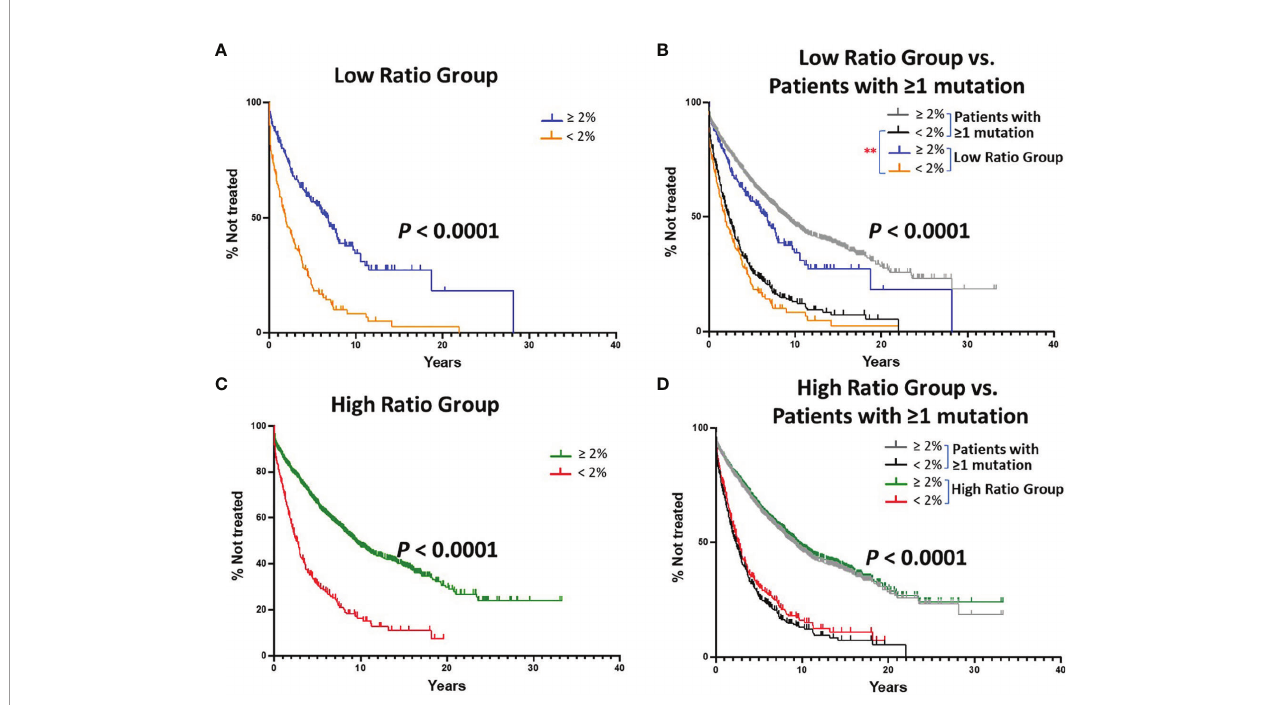
FIGURE 2 | Kaplan-Meier estimates of TTFT of patients with IGHV sequences bearing at least 1 somatic mutation divided into Low or High (S+Rc)/Rnc Ratio Groups. (A) TTFT of patients with IGHV genes falling into the “ Low Ratio Group ” , ≤ 1.0 (S+Rc)/Rnc (n = 405) were compared based on the < 2% vs. ≥ 2% difference from the germline IGHV sequence. Number of cases in the < 2% difference group: 183, 152 treated (median TTFT = 1.91 years); number of cases in the ≥ 2% difference group: 222, 119 treated (median TTFT = 6.78 years) (P < 0.0001). (B) TTFT of all patients ( Figure 1B ) and those sequences in Low Ratio Group based on the < 2% vs. ≥ 2% difference from the germline IGHV sequence. ** = P < 0.01 Pair-wise Log-rank (Mantel-Cox) test. (C) TTFT of patients in the High Ratio Group, > 1.0 (S+Rc)/Rnc) (n = 1,934) compared based on the 2% cutoff. Number of cases in the < 2% difference group: 271, 199 treated (median TTFT = 2.59 years); number of cases in the ≥ 2% difference group: 1,663, 737 treated (median TTFT = 9.38 years) (P < 0.0001). (D) TTFT based on the < 2% vs. ≥ 2% difference from the germline IGHV sequence using all patient sequences ( Figure 1B ) and those sequences in High Ratio group. ** = P < signi fi cantly longer TTFTs for the ≥ 2% ( Figure 3A ; median TTFT: 6.78 vs. 9.38 yrs; P = 0.0009) and the < 2% ( Figure 3B ; median TTFT: 1.91 vs. 2.59 yrs; P = 0.0053) categories than the Low Ratio Group.